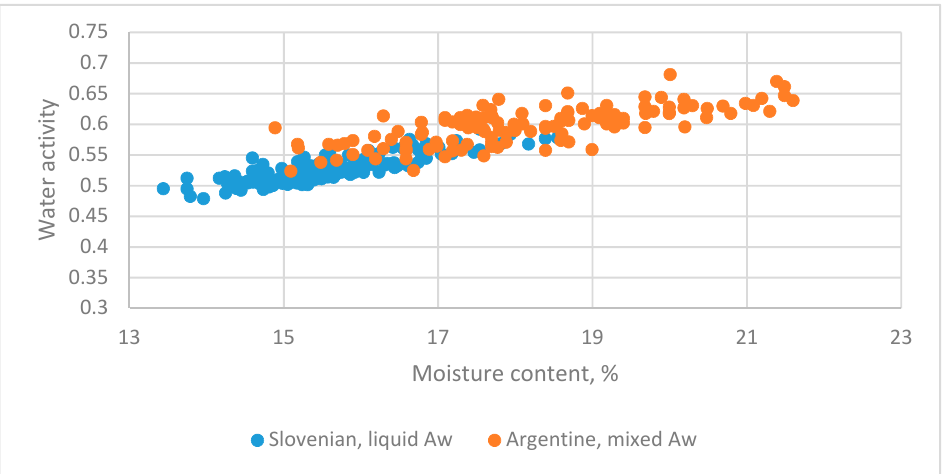
Figure 10. The relationship between water activity and moisture content for datasets for honey of different types and states [13] and Slovenia (pooled data of liquid states: flower and honeydew) [5].